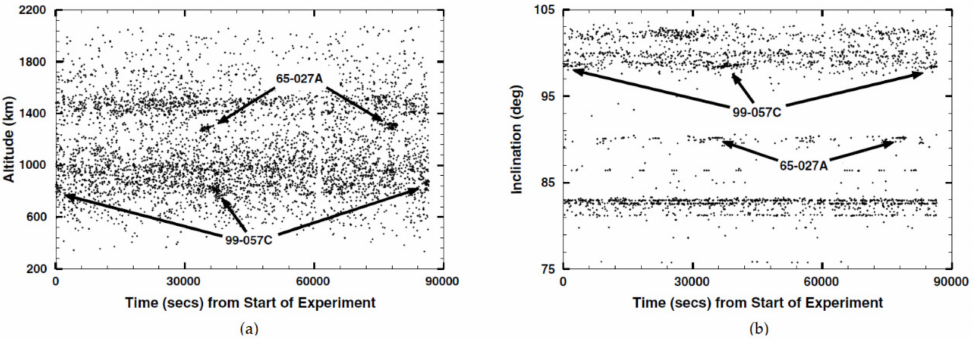
Figure 11. Distribution of the altitude ( a ) and inclination ( b ) of the objects detected by Cobra Dane during 2000 BPE [26]. Reprinted from European Space Agency Publications, Copyright 2001, with permission from NASA.